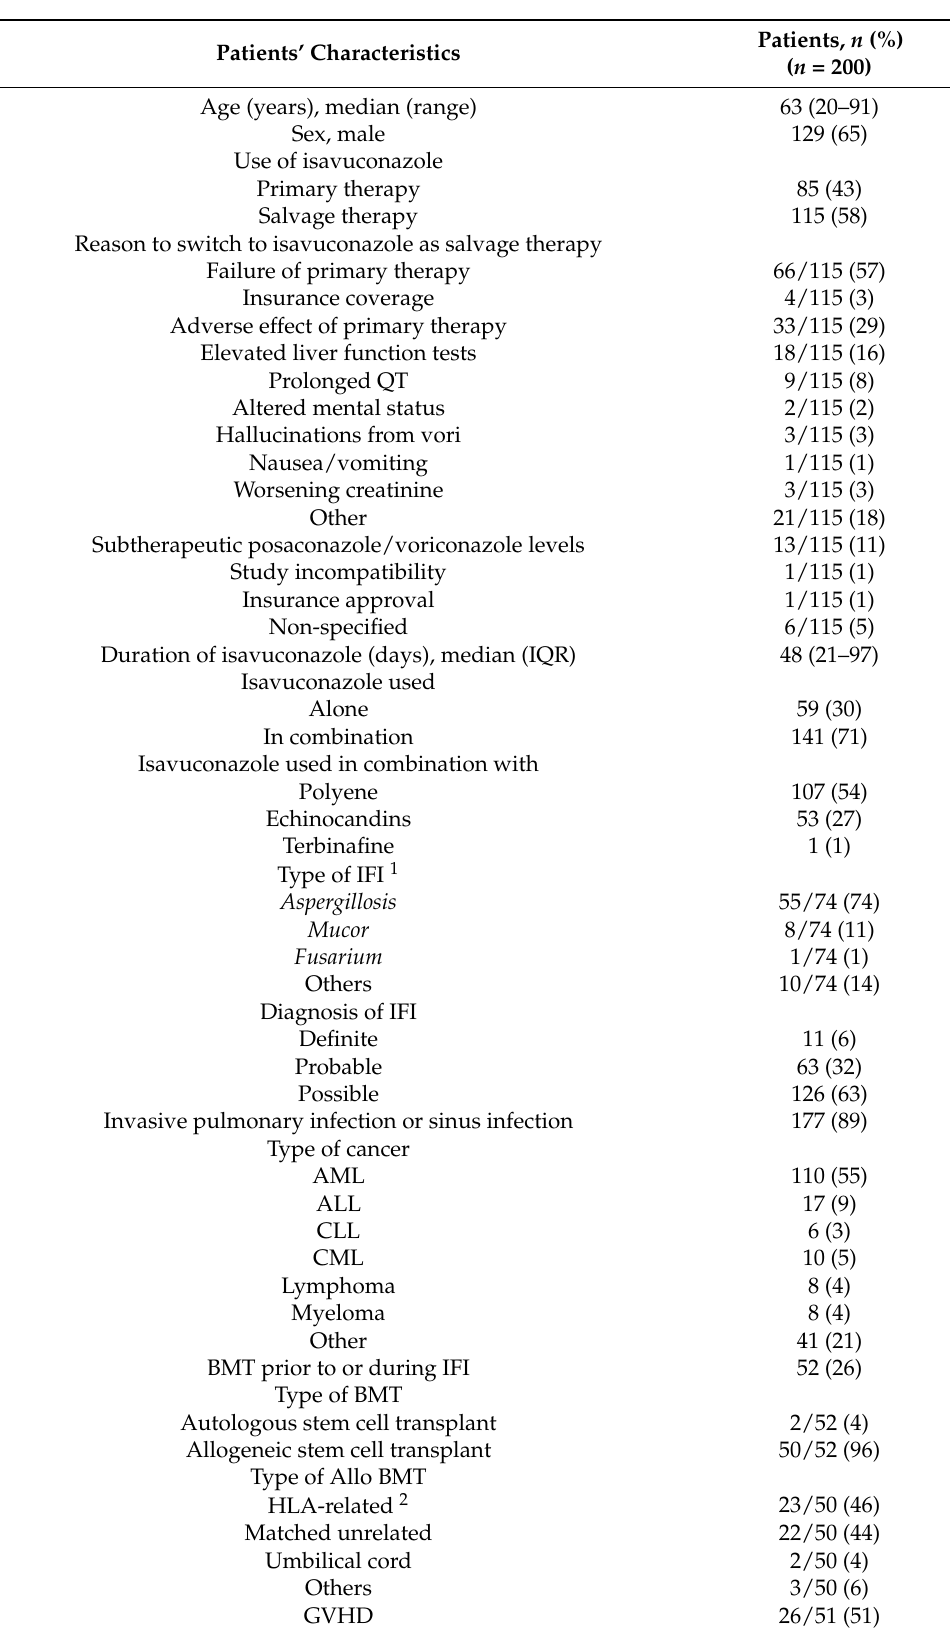
Table 1. Patient Characteristics and